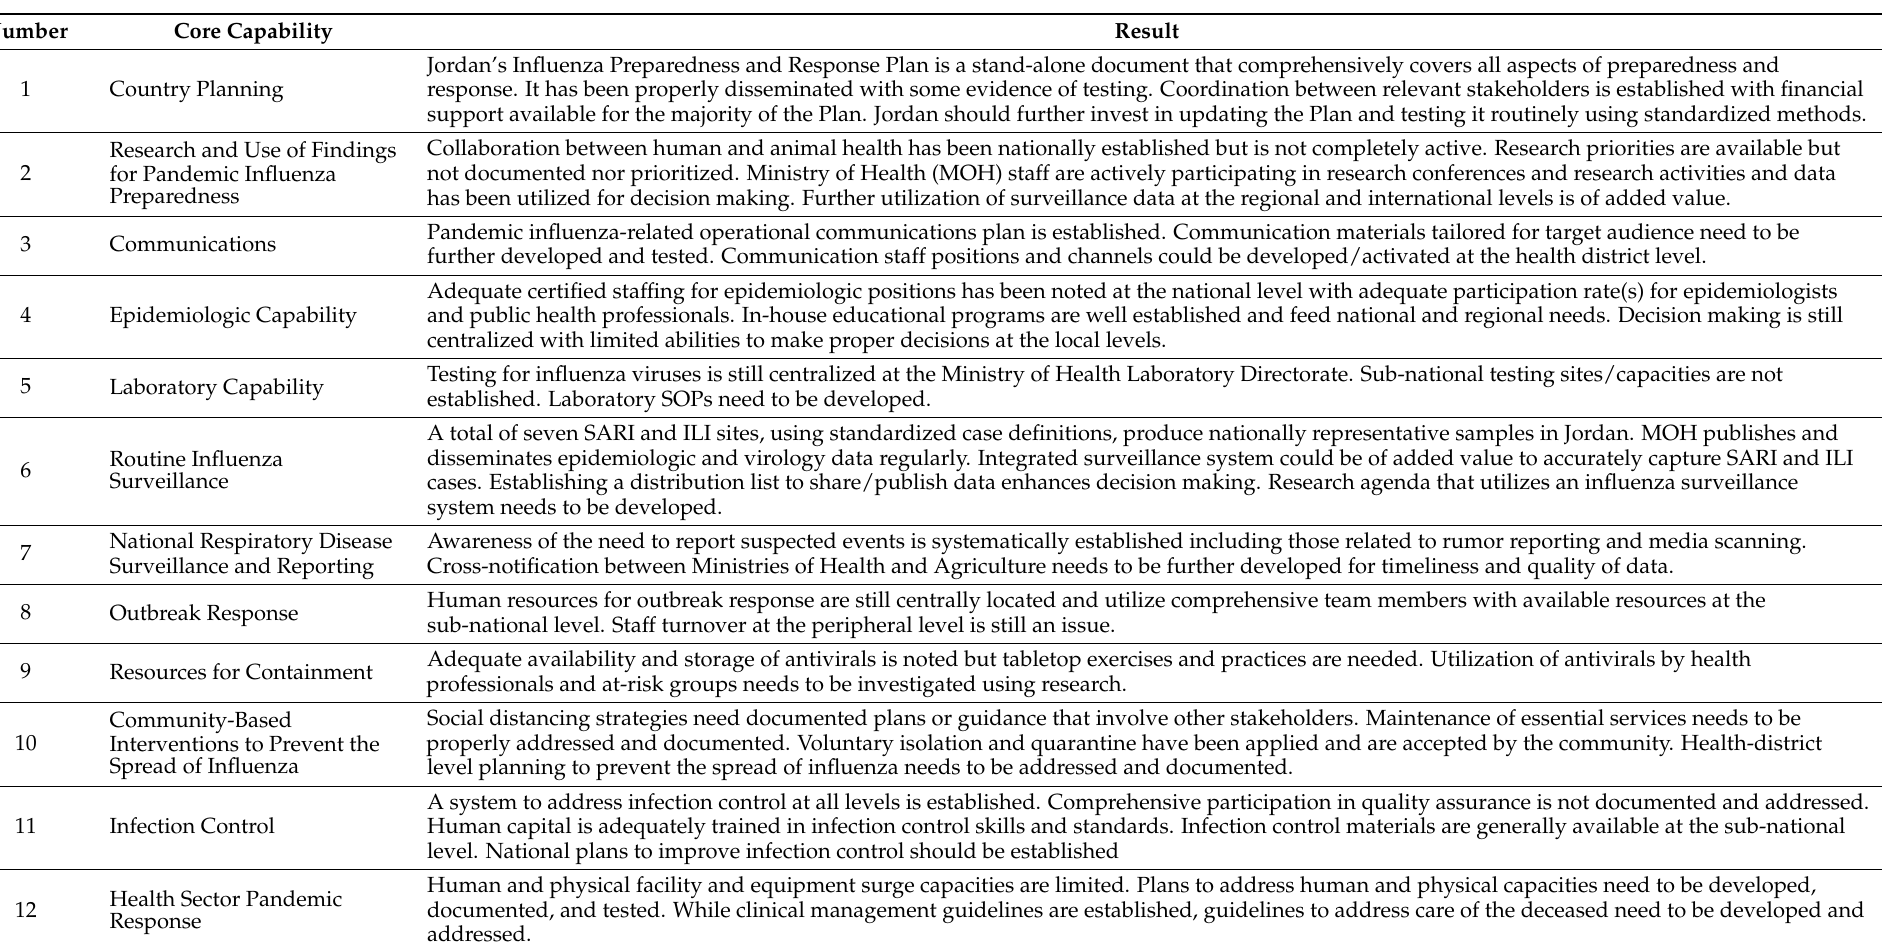
Table 1. Overview of 2018 Jordan’s twelve core capabilities of the CDC Pandemic Influenza Preparedness and Response